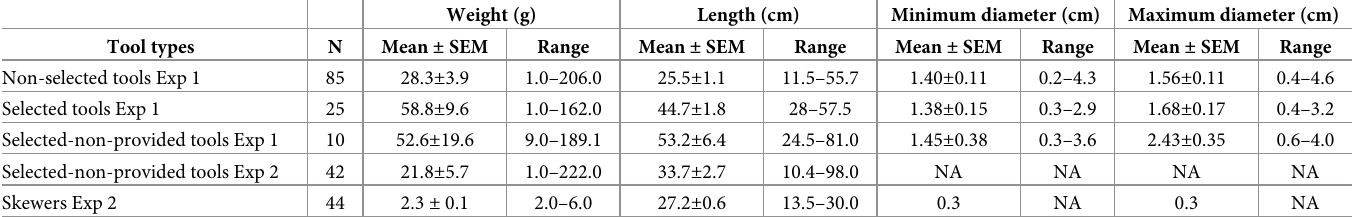
Table 5. Tool dimensions. a) Tools provided to the chimpanzees during Experiment 1—those that they used as tools (Selected tools Exp 1) and those that they did not (Non-selected tools Exp 1); b) tools the chimpanzees obtained themselves from the natural vegetation of the island during Experiment 1 (Selected-non-provided tools Exp 1) and Experiment 2 (Selected-non-provided tools Exp 2). Diameters were not measured for these tools; c) Bamboo skewers (from the flags used to mark the presence of buried food) the chimpanzees used in Experiment 2 (Skewers Exp